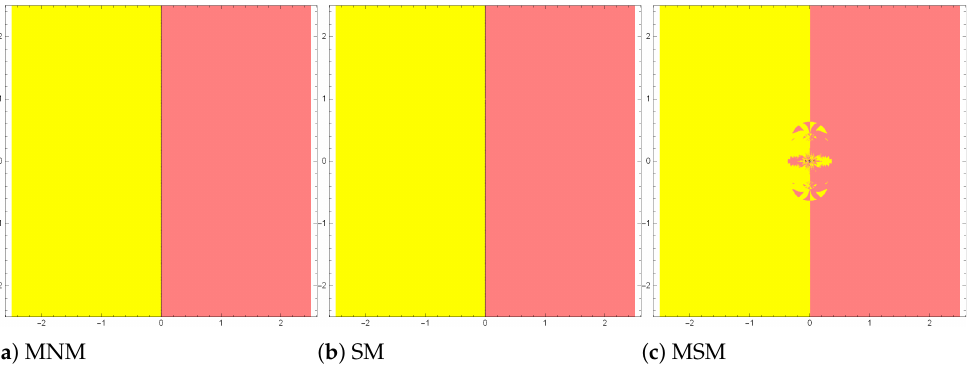
Figure 3. Dynamical planes of new and existing methods for Example